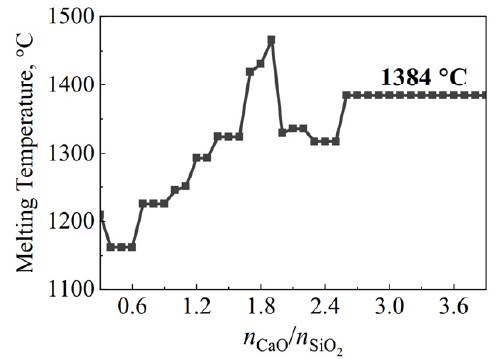
Figure 16. Onset melting temperature of the cementitious material system.